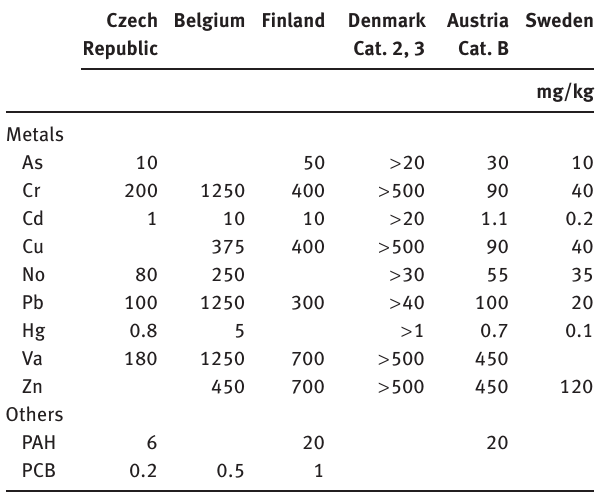
Table 3: Comparison of limits for C&DW Europe-wide [11].